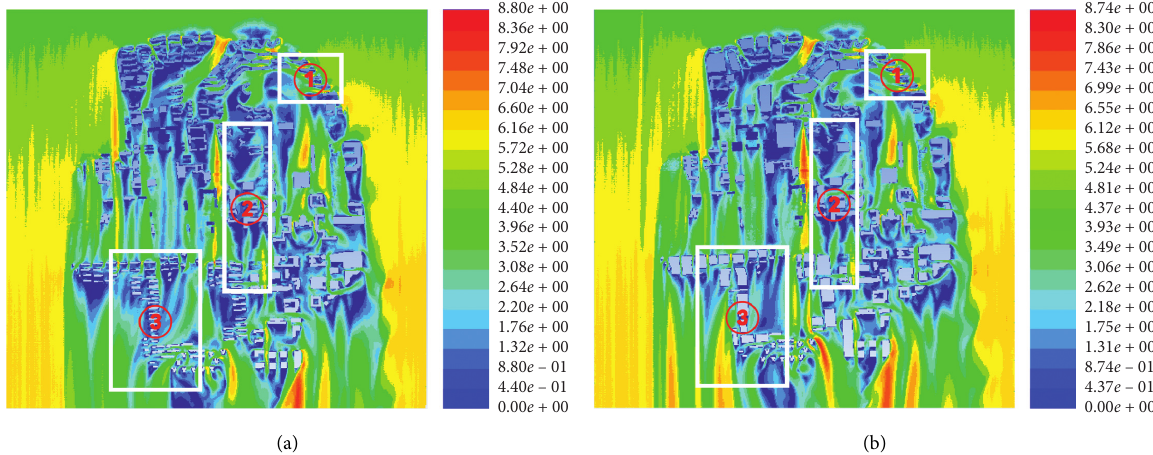
Figure 12: Velocity contour cloud maps before and after simplification. (a) Velocity contour cloud map before simplification. (b) Velocity contour cloud map after simplification.